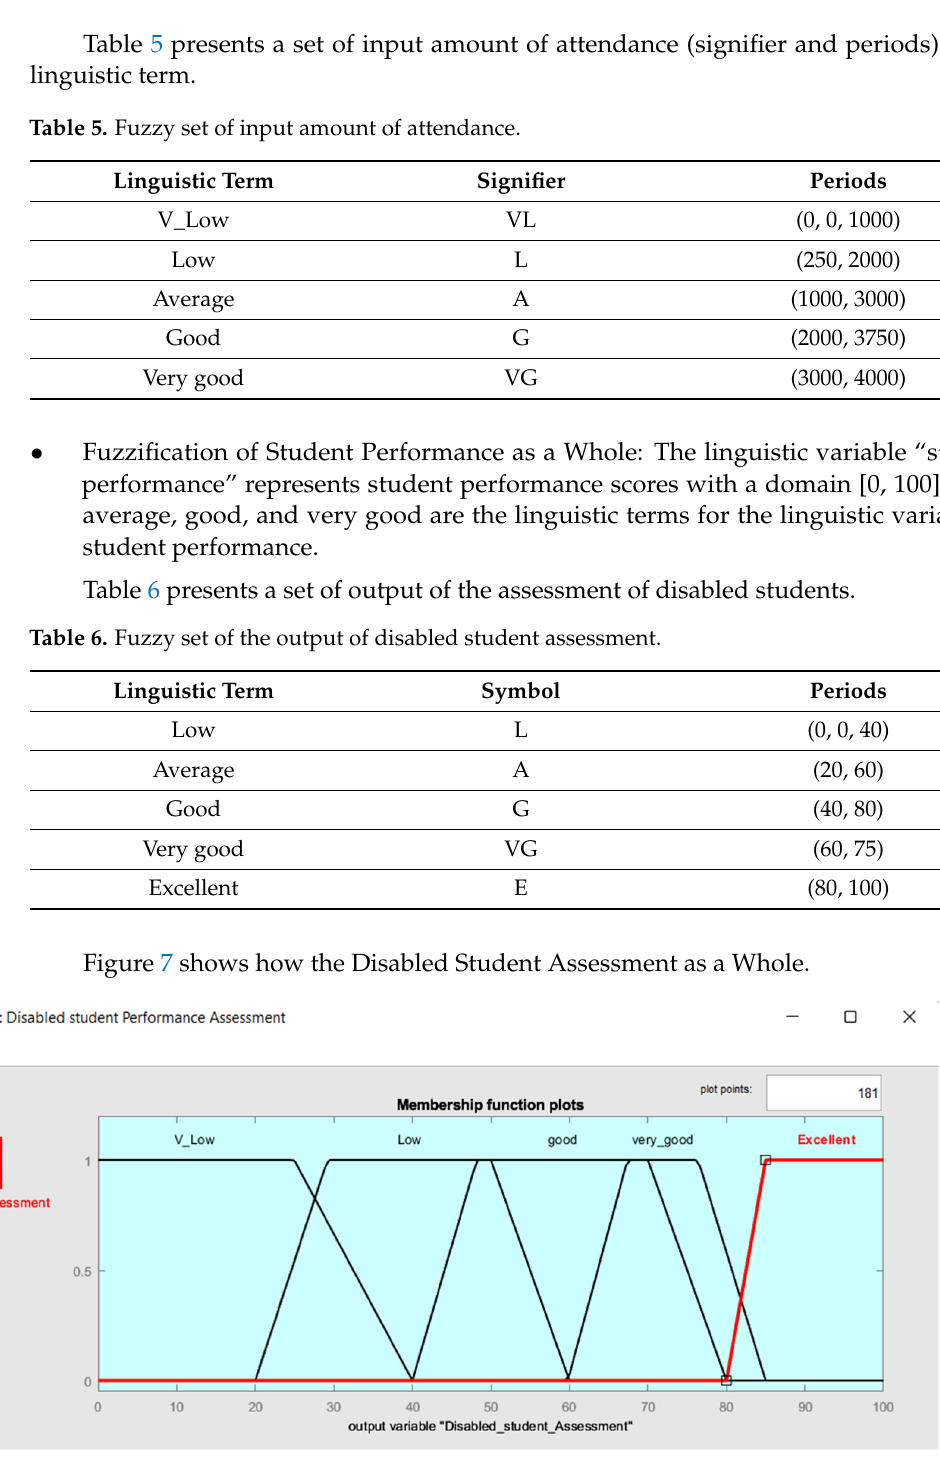
Figure 7. The Output of the Disabled Student Assessment as a Whole.